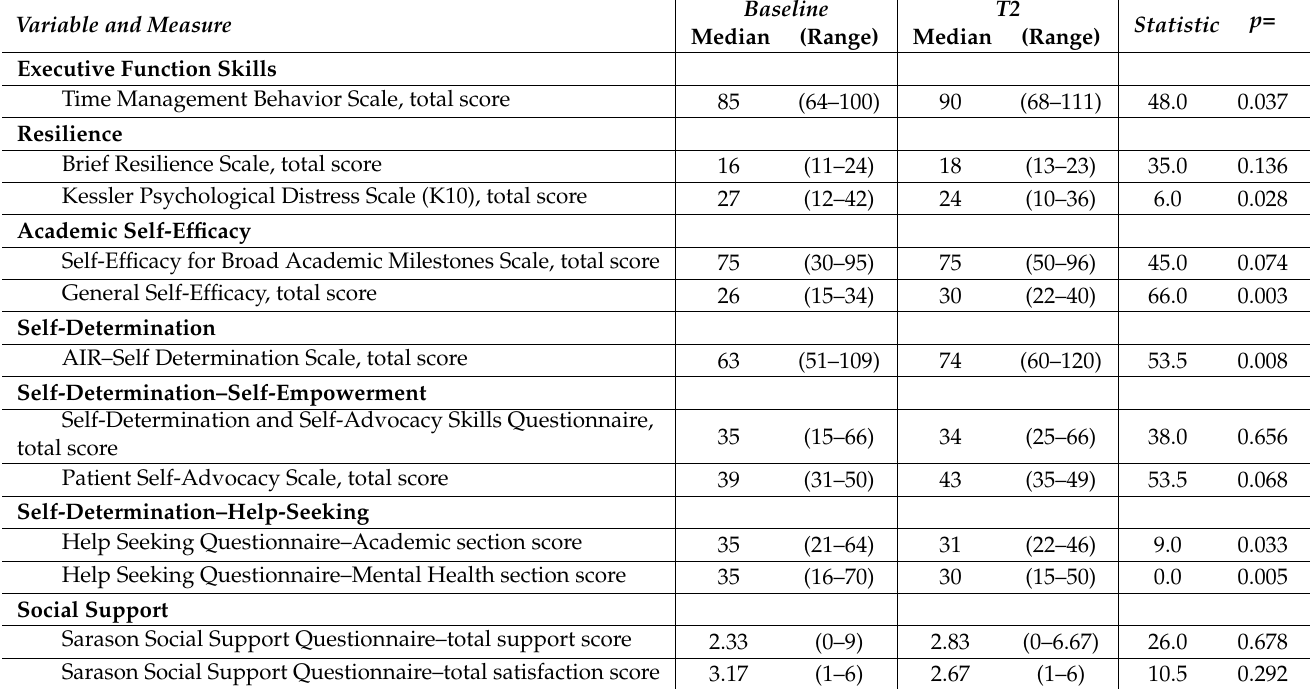
Table 3. Baseline to end of Semester 2 (T2) comparisons of instrumental outcomes for n = 10 students receiving PASS